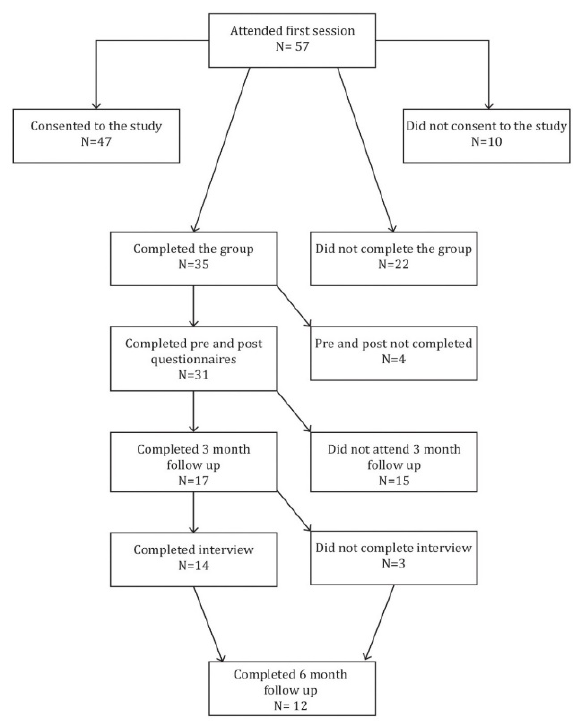
Figure 1. Participant attrition through the data collection period.